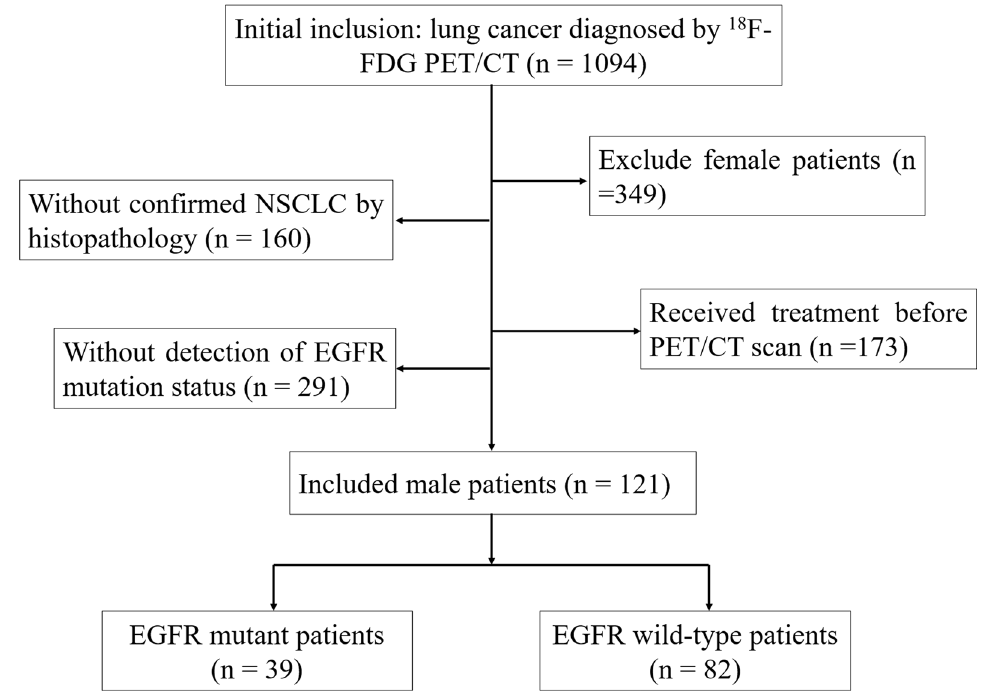
Fig. 1 Study design and patient selection